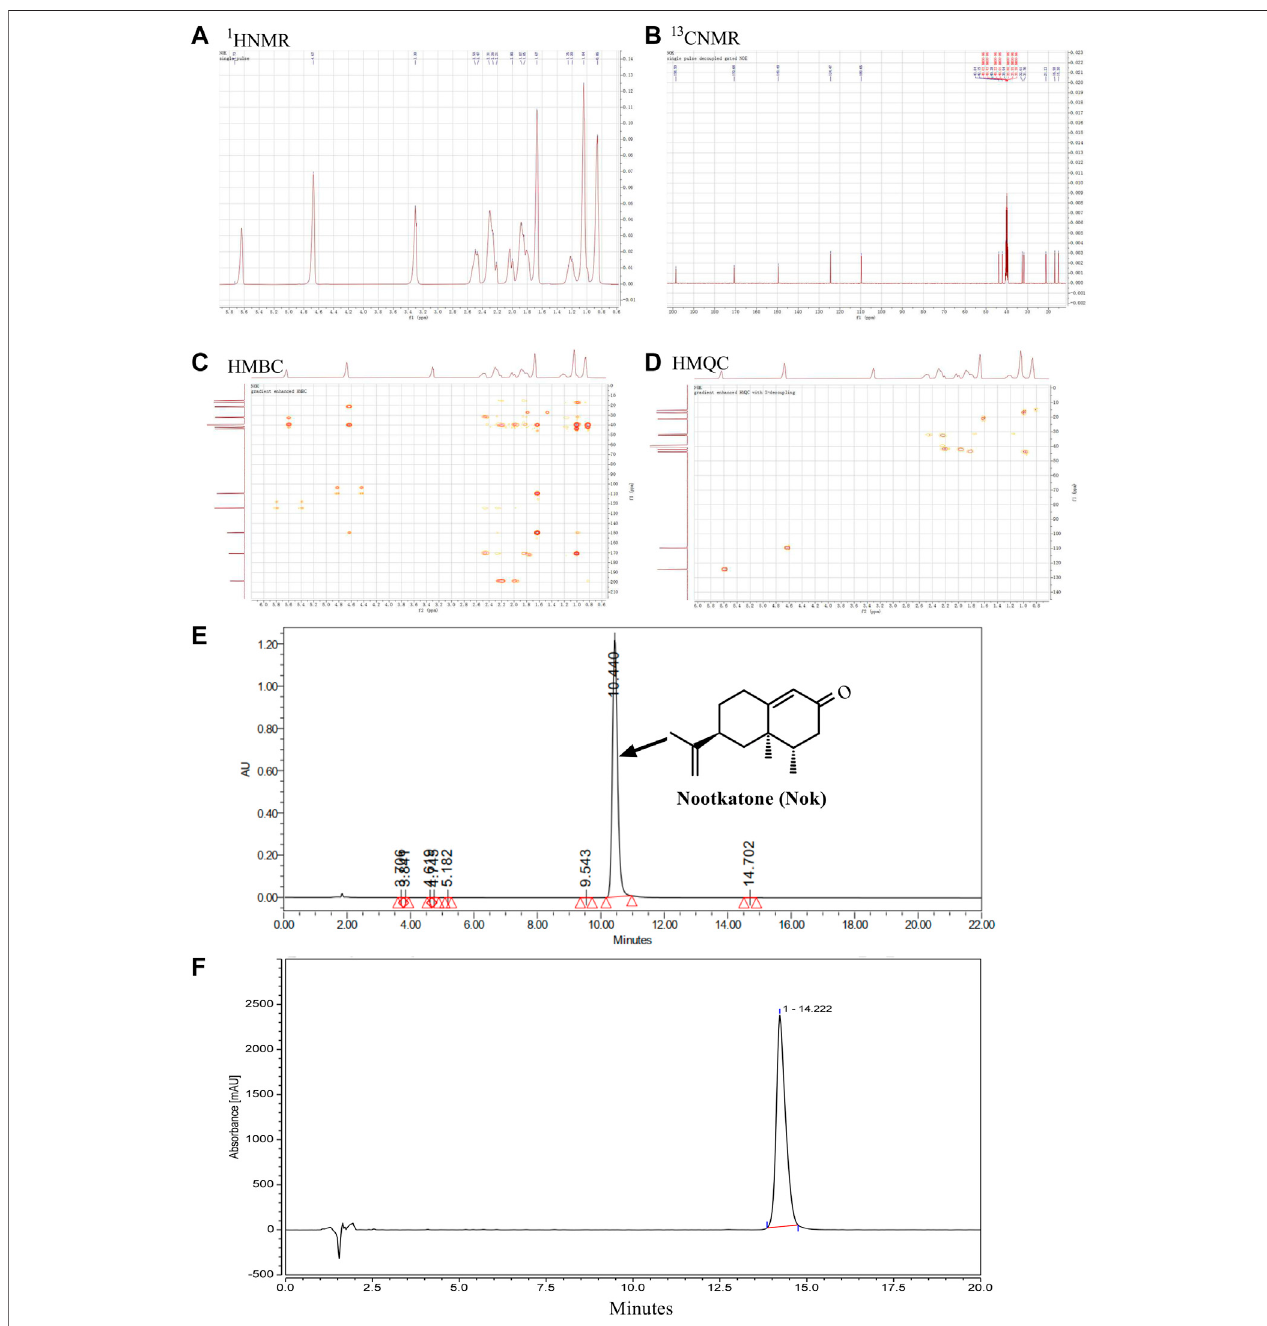
FIGURE 1 | Isolation and structural characterization of nootkatone. (A) The structure and 1 H-NMR spectrum of Nok (B) 13 C-NMR spectrum of Nok; (C) HMQC spectrum of Nok (D) HMBC spectrum of Nok. (E) HPLC of Nok from Alpiniae oxyphyllae Fructus. (F) HPLC of Nok from Chengdu Biopurify Phytochemicals Ltd.